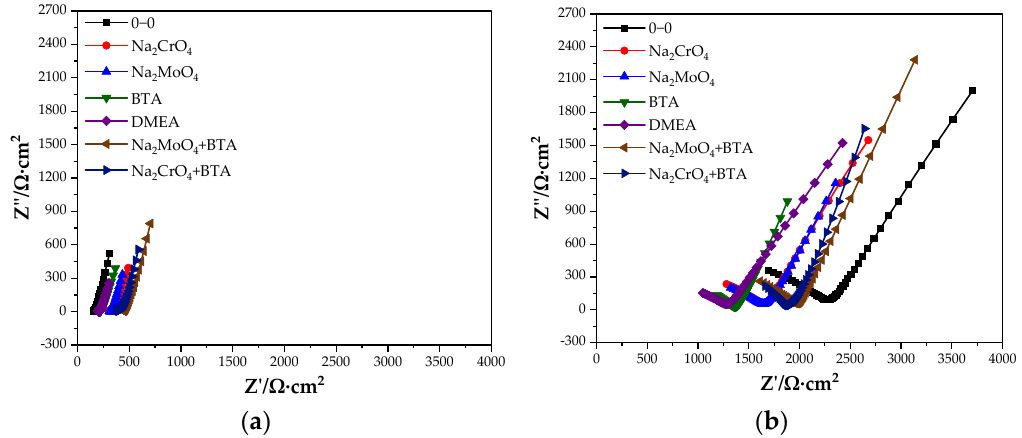
Figure 2. Nyquist diagram of the specimen with the rust inhibitor. ( a ) 28 days. ( b ) 90 days.